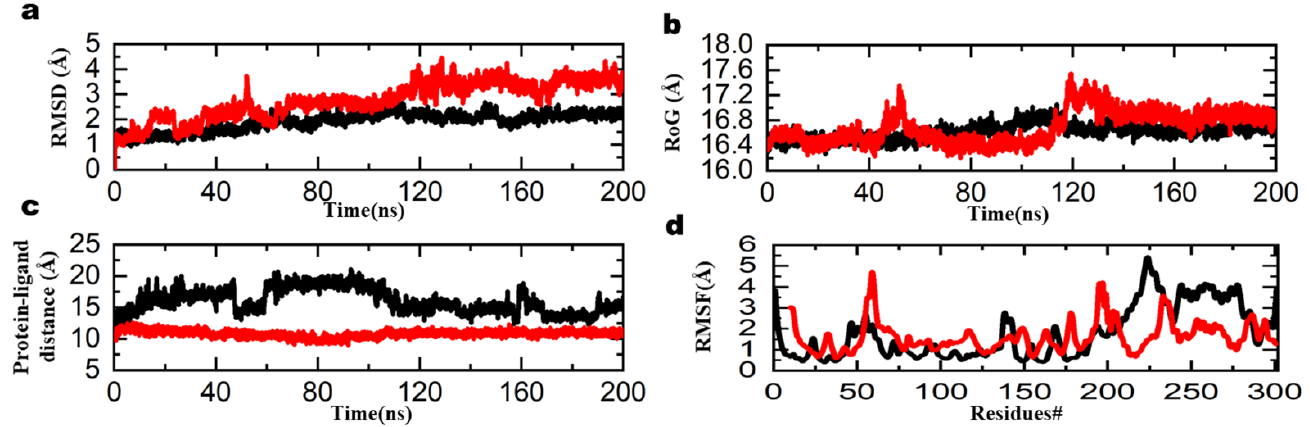
Figure 7. Dynamics stability of the top 2 molecules: ( a ) RMSD, ( b ) RoG, ( c ) protein-ligand distance, ( d ) RMSF.